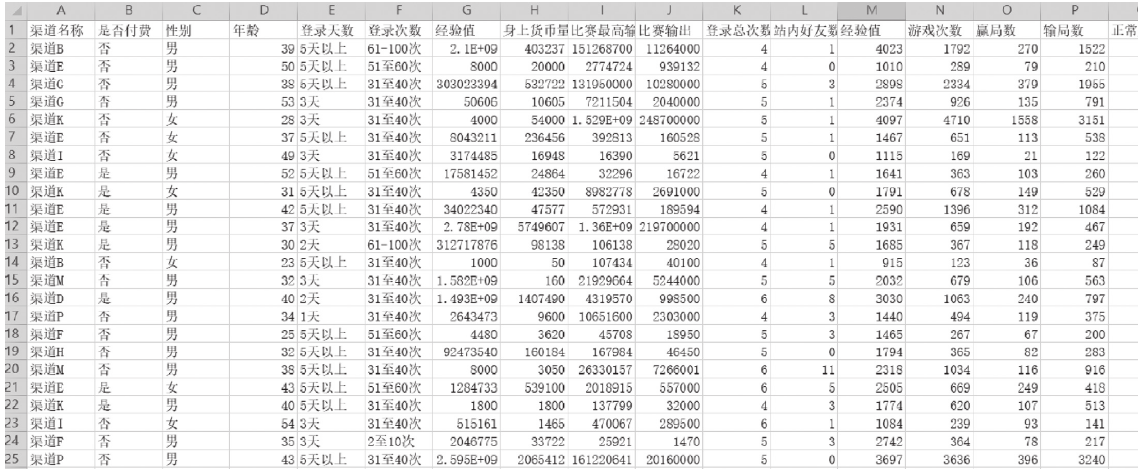
Figure 4: Player behavior consumption data set display.